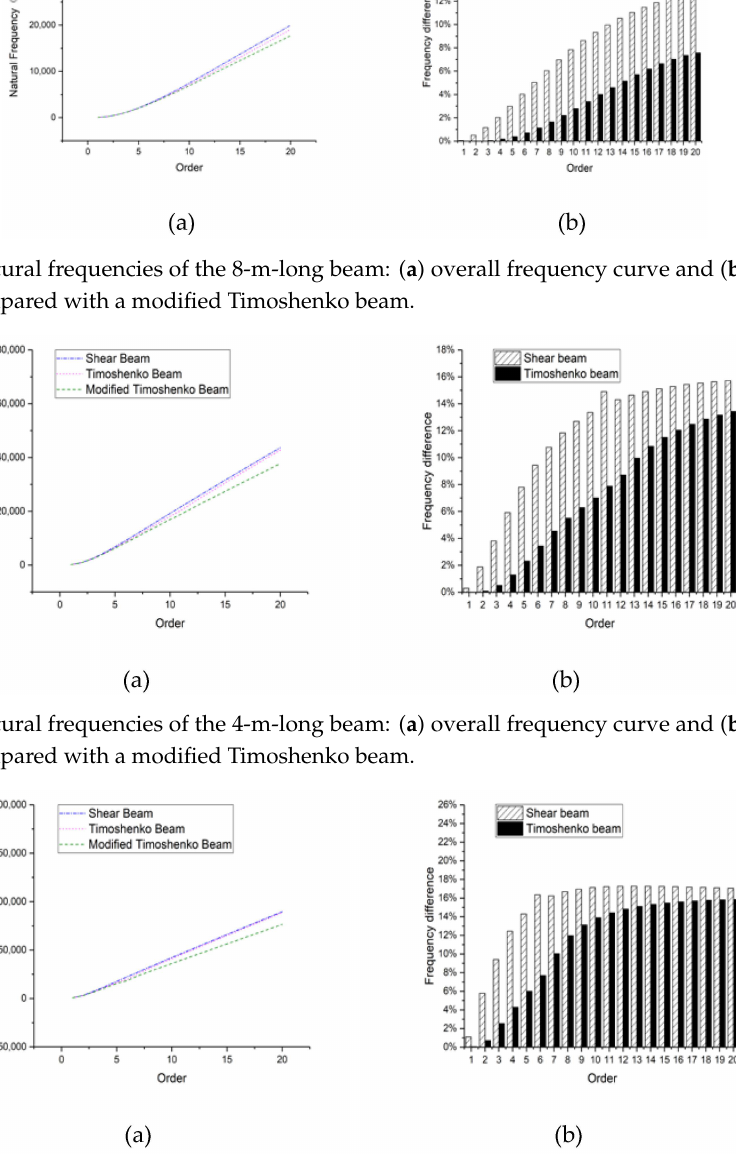
Figure 12. Natural frequencies of the 2-m-long beam: ( a ) overall frequency curve and ( b ) frequency di ff erence compared with a modified Timoshenko